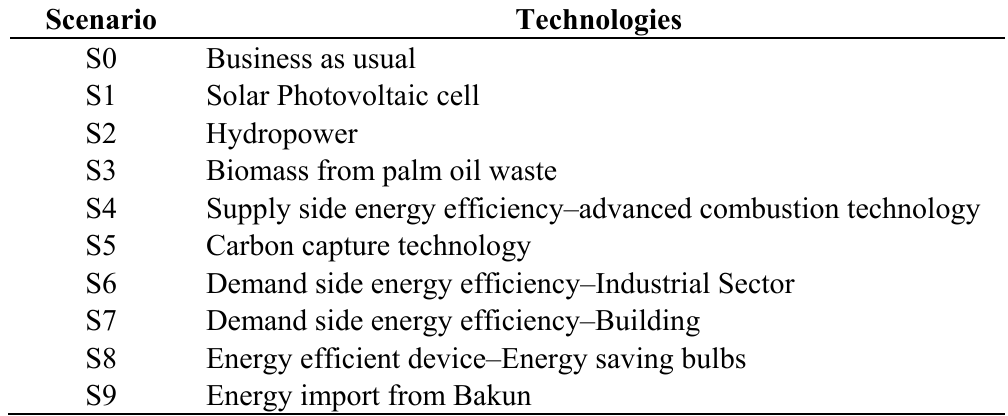
Table 1. Key technologies applied in the